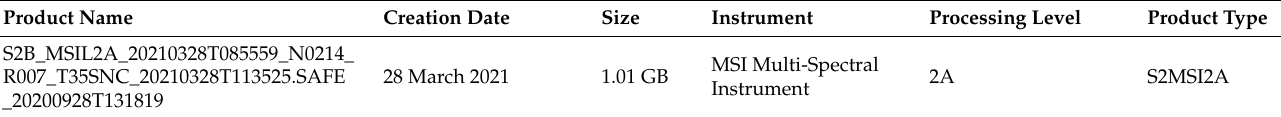
Table 1. Characteristics of the originally downloaded Sentinel image.